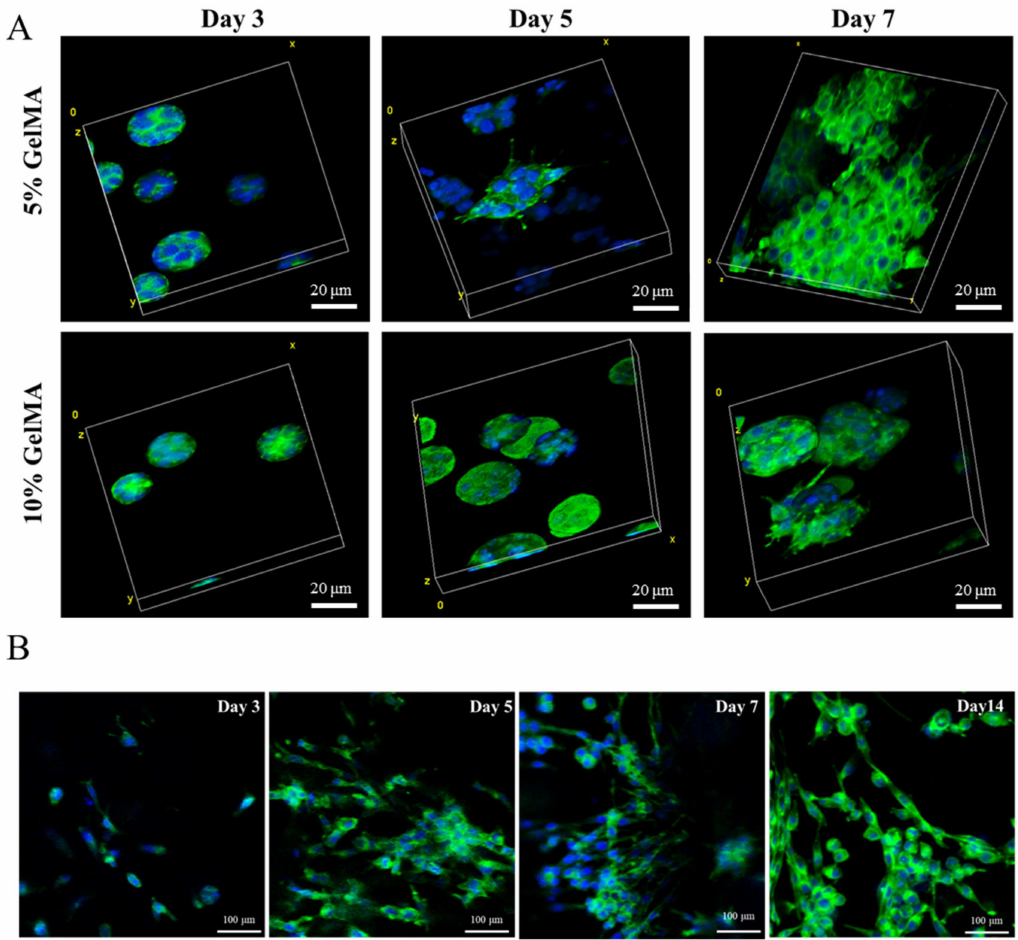
Gels 2022 , 8 , x FOR PEER REVIEW 7 of 15 Figure 3. Cell morphology of SCs embedded 5% and 10% GelMA. ( A ) Confocal laser microscopy images of SCs stained with phalloidin (green) and cell nuclei (blue) after culturing 3, 5, and 7 days. ( B ) Immunofluorescent staining of SCs embedded in 5% GelMA after 3, 5, 7, and 14 days of culture.